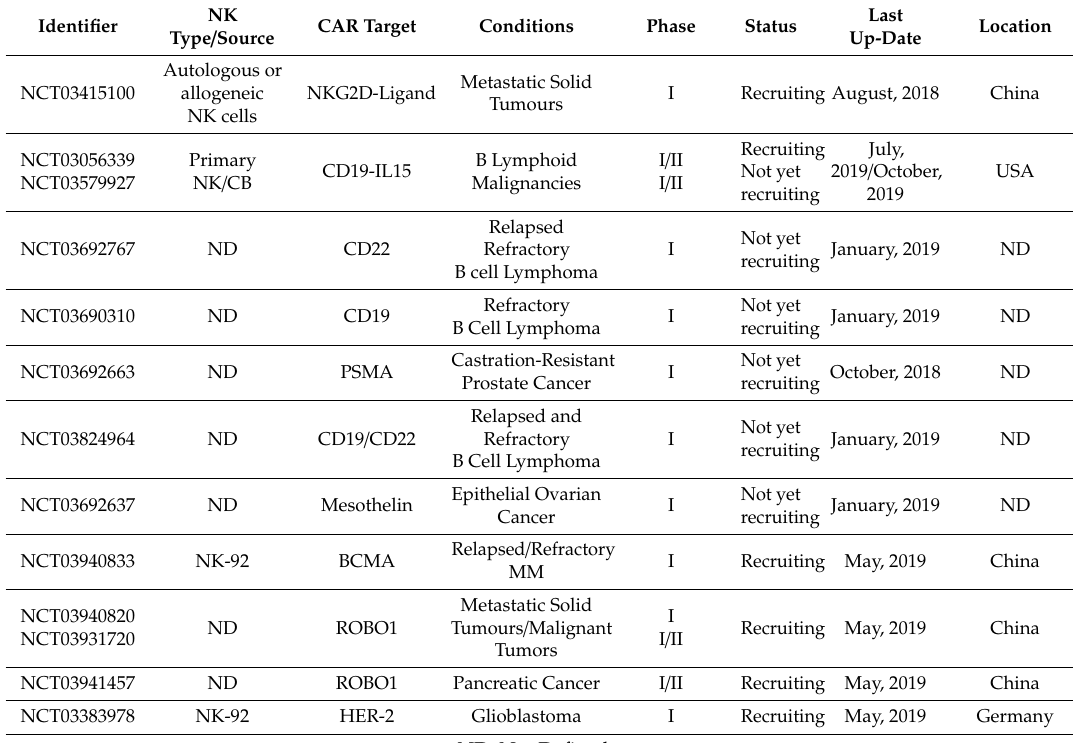
Table 1. Active clinical CAR NK cell trials with a known status (source: